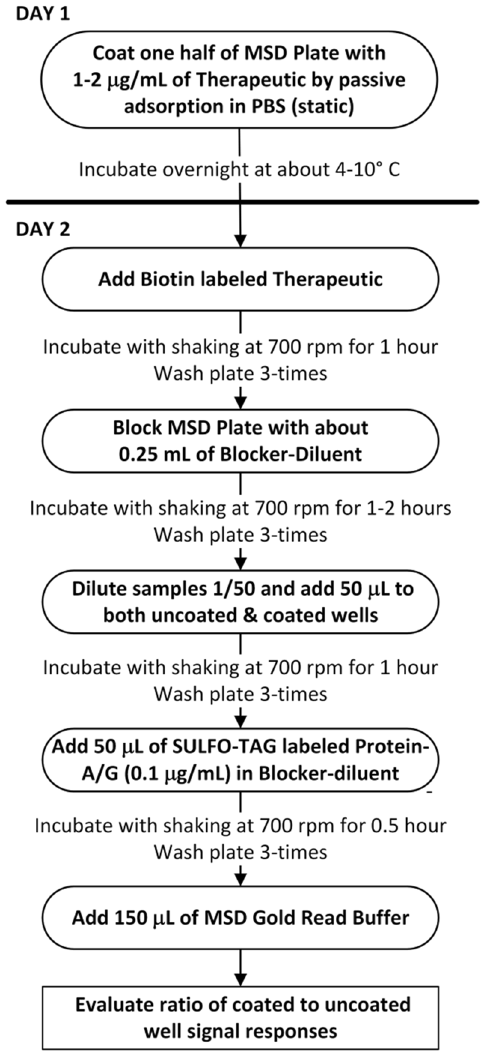
Figure 6. Workflow for Tier 1 screening ADA assay using SULFO-TAG labeled